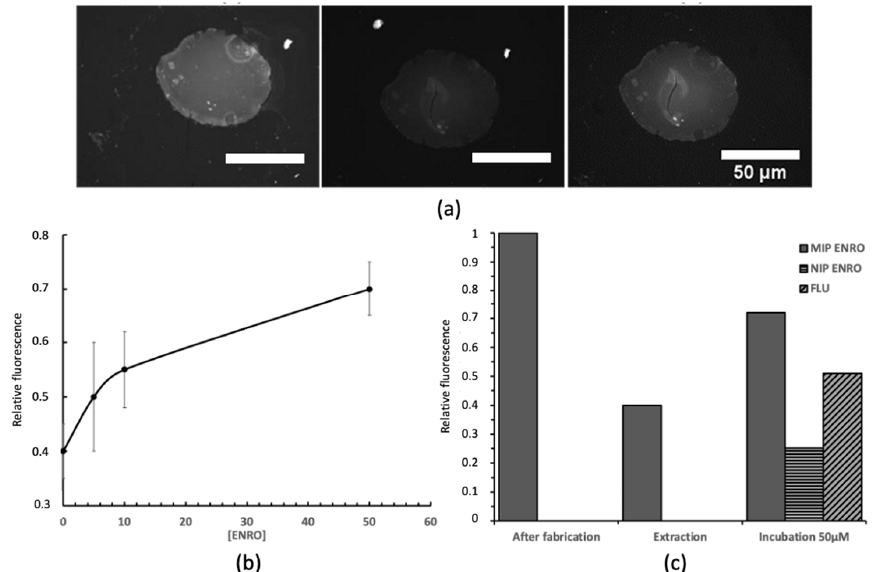
Figure 6. ( a ) Enrofloxacin-imprinted structure after fabrication, extraction, and binding 50 μ M of enrofloxacin; ( b ) binding results with 5, 10, and 50 µ M of enrofloxacin; the number of experiments n = 3, error bars represent the standard error of the mean; ( c ) specificity and selectivity studies with 50 μ M of enrofloxacin on both MIP and NIP vs. 50 μ M of flumequine.